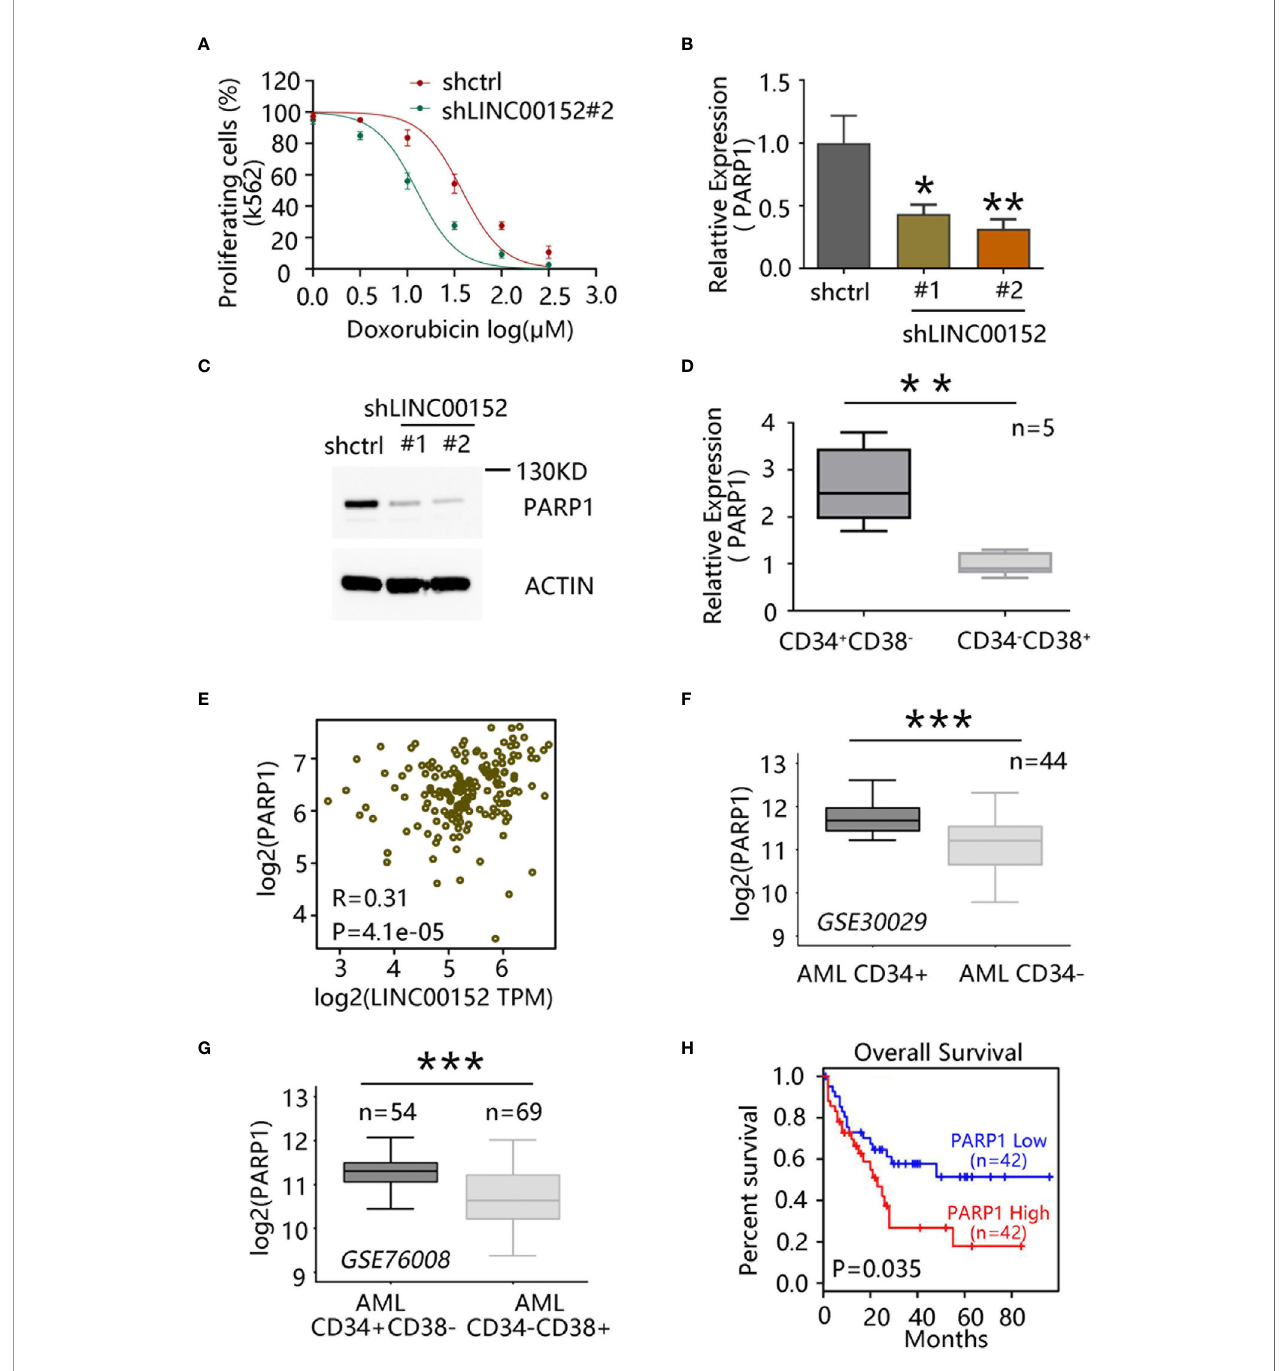
FIGURE 4 | LINC00152 regulates chemoresistance of leukemia stem cells (LSCs) via PARP1. (A) Doxorubicin sensitivity assay after LINC00152 knockdown in K562 cells. (B) PARP1 mRNA level after LINC00152 knockdown compared with control acute myeloid leukemia (AML) cells (* P < 0.05, ** P < 0.01). (C) PARP1 expression at the protein level after LINC00152 knockdown compared with control AML cells. (D) PARP1 expression in CD34 + CD38 − and CD34 − CD38 + cells derived from fi ve AML patients. Data are represented as the mean ± SD of three independent experiments (** P < 0.01). (E) Expression of LINC00152 was correlated with that of PARP1 in AML based on a publicly available data set by gene expression pro fi ling interactive analysis. (F) PARP1 expression in paired CD34 + cells vs. CD34 − cells (GSE30029, *** P < 0.001). (G) PARP1 expression in CD34 + CD38 − vs. CD34 − CD38 + cells (GSE760008, *** P < 0.001). (H) Correlation between overall survival of AML patients and PARP1 expression based on a publicly available data set (GSE76009) by gene expression pro fi ling interactive